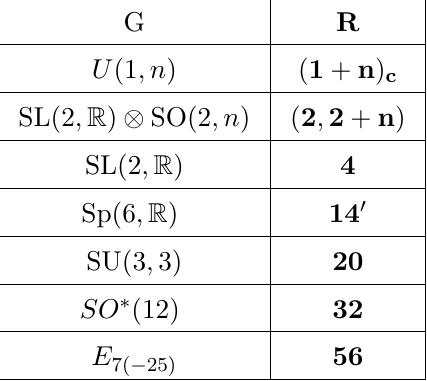
of the G symmetric spaces and their symplectic representations H G = 2 N